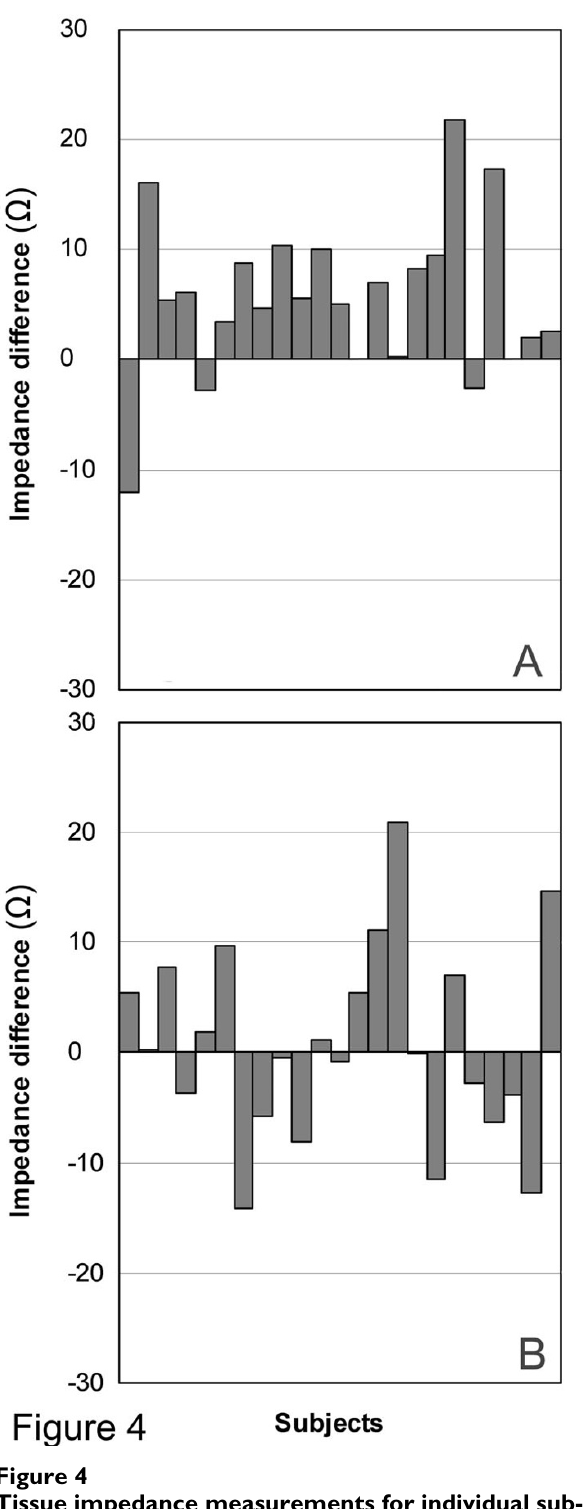
Figure 4 Tissue impedance measurements for individual sub- jects. The difference in impedance between control and meridian segments (Impedance difference) is shown for the Pericardium (A) and Spleen (B) meridian